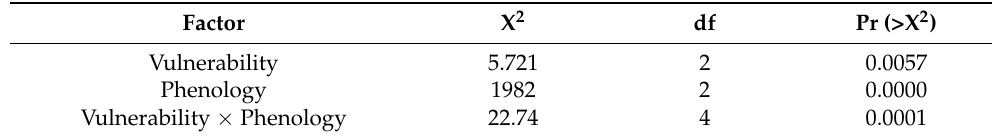
Table 4. Model 2, deviance table of the “Nested, no Practice factor” optimal model for the average NDVI at plot level (df: degrees of freedom).